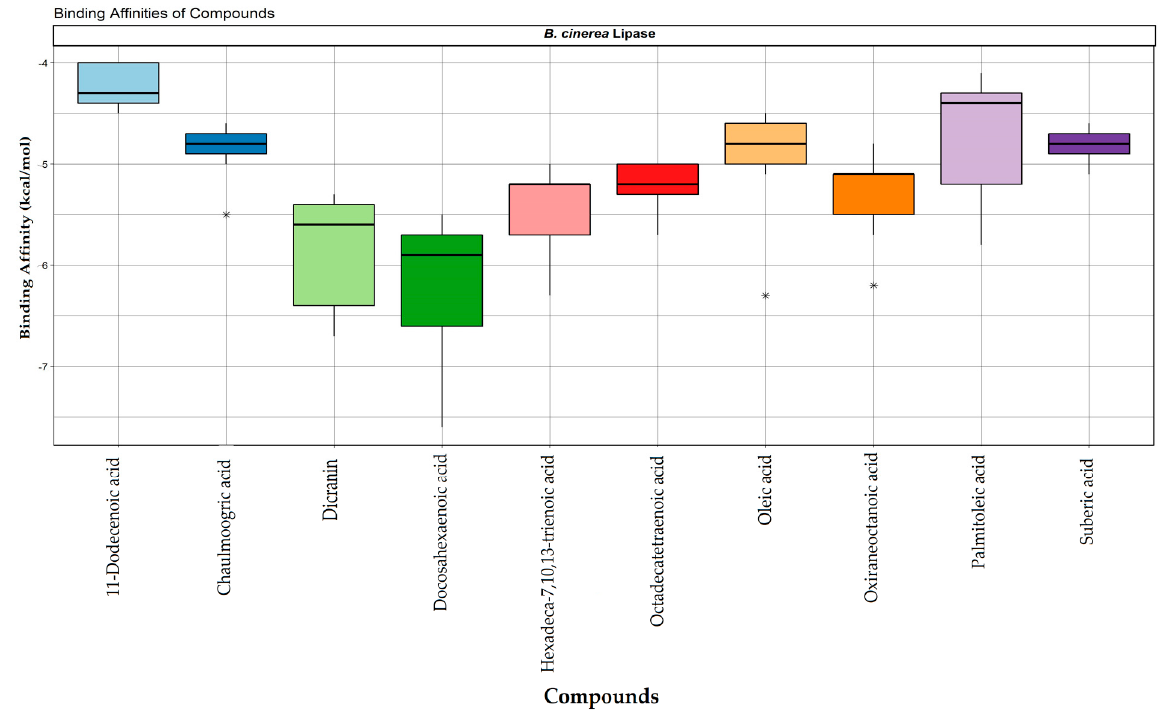
Figure 9. Boxplot of the top ten plant triglycerides. The top ten plant triglycerides showed the differential binding affinities pattern. Dicranin, docosahexaenoic acid, and hexadeca-7,10,13-trienoic acid showing the smallest binding energy values, which dictate a stronger binding interaction with the lipase.